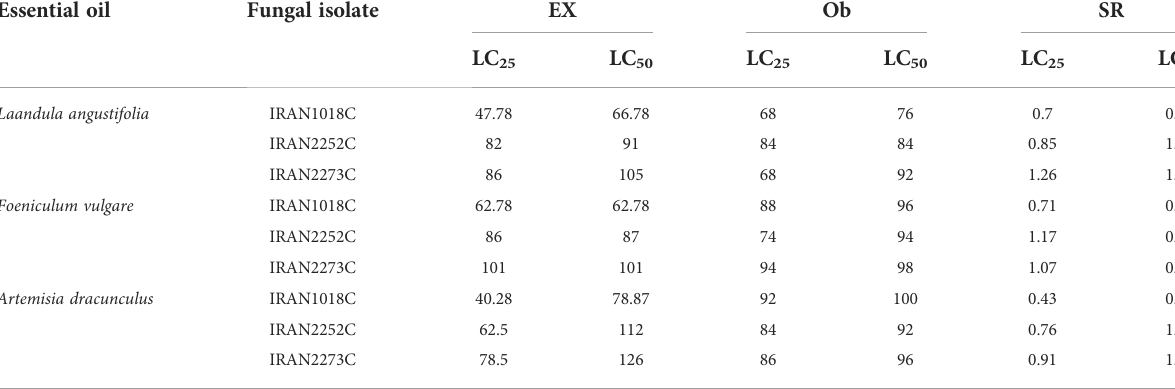
TABLE 4 Toxicity of LC 25 and LC 50 of essential oils with 10 4 (spore/ml) of IRAN1018C, IRAN2252C, and IRAN2273C isolates of M. anisopliae against adult A. obtectus after 24 h. Essential oil